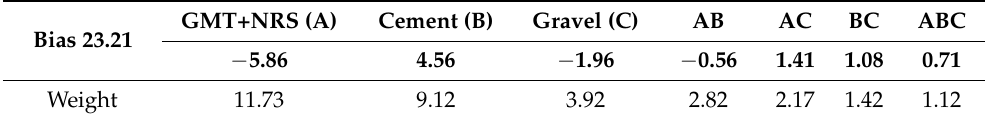
Table 6. Degree of influence of the concrete constituents of the DOE. Bias 23.21